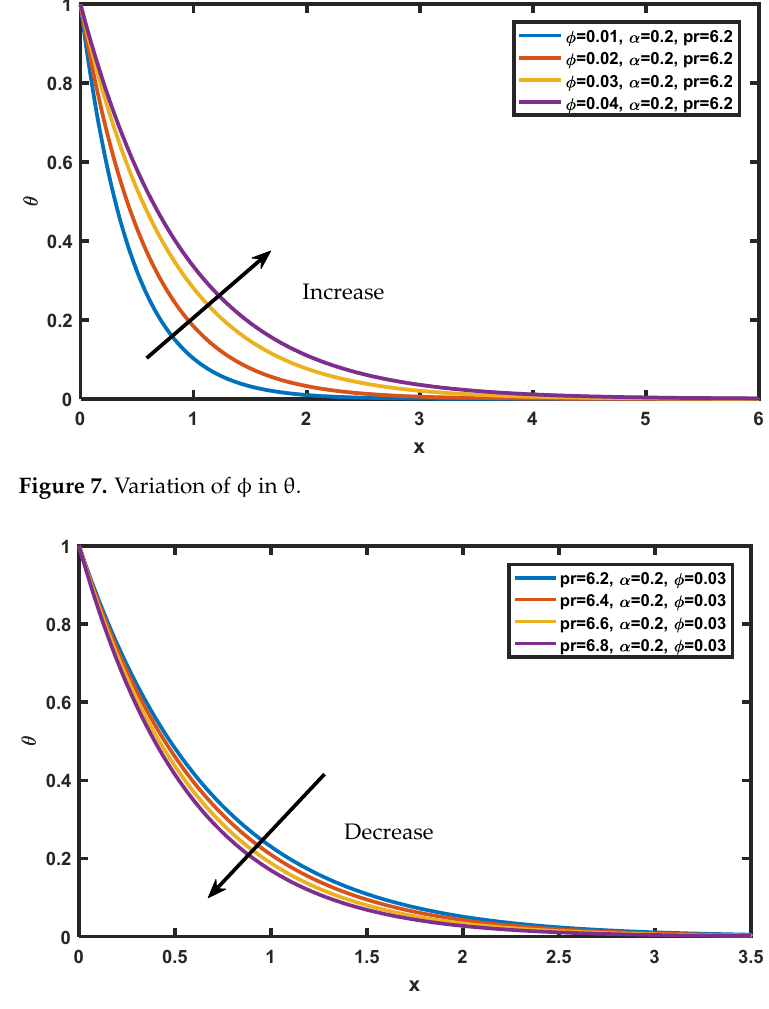
Figure 8. Variation of Pr in θ.